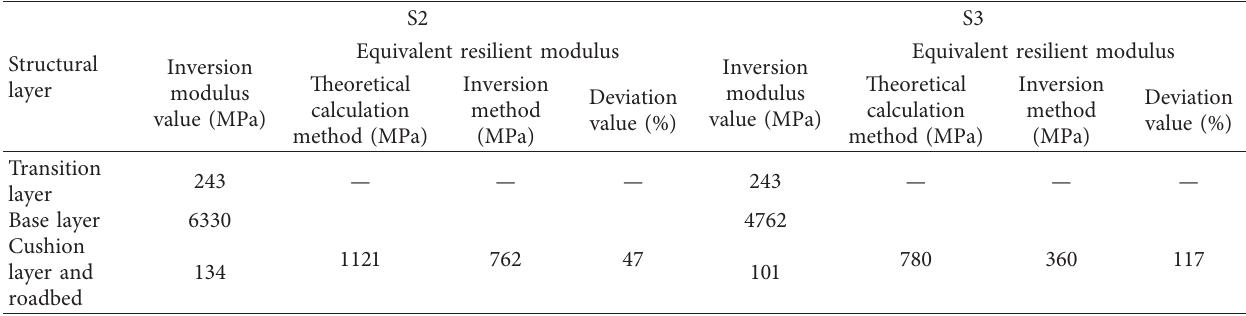
Table 5: The calculation of the equivalent resilient modulus of the top surface of the base layer when FWD is loaded on the top surface of the transition layer.